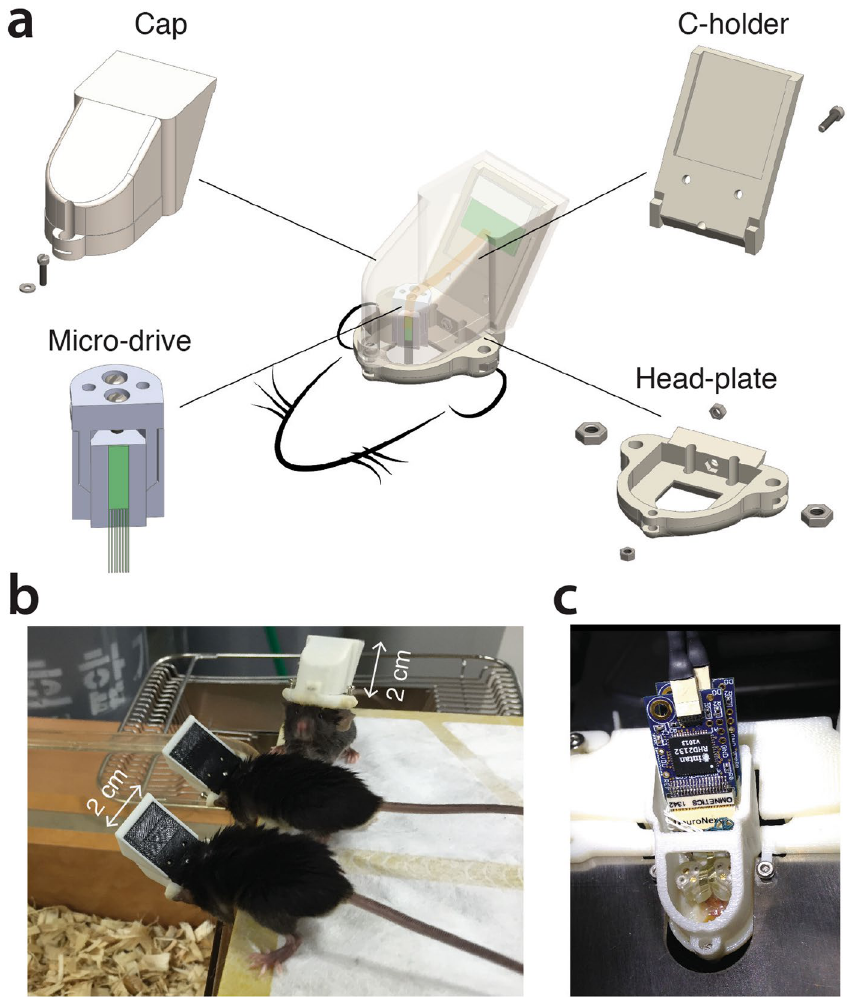
Figure 1. Hat enclosure for chronic recordings, in head-fixed or freely moving mice. ( a ) Micro-drive (lower left), cap (upper left), C-holder (upper right) and head-plate (lower right). ( b ) Mice wearing the hat enclosure. ( c) Modified cap that allows access to connectors and